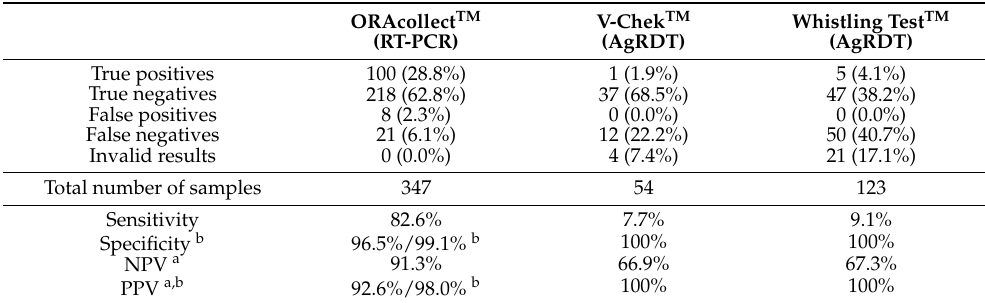
Table 1. Overview of the results for each saliva method compared to the nasopharyngeal swab.